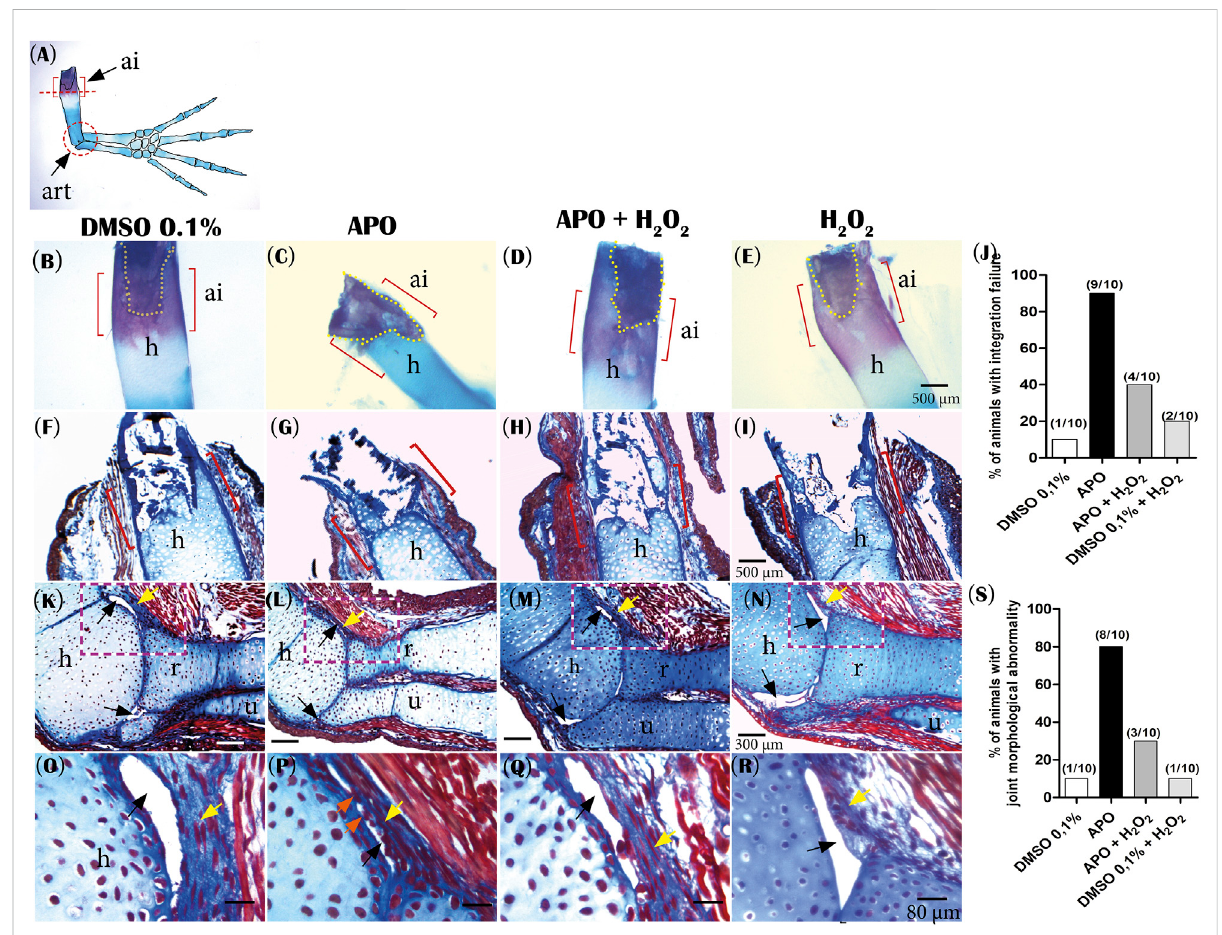
FIGURE 5 Inhibitory treatment of NOXs-dependent ROS production affects the integration of the regenerated skeleton and joint morphology in A. mexicanum at 72 dpa. (A) , Illustration of the areas of interest evaluated: ai (integration area) delimited with red brackets. The red circle indicates the jointareastudied. (B – E) ,representativeimagesoftheexperimentalgroupsevaluatedbyalcianblueandalizarinredstaining:Controlsin0.1%DMSO, apocynin (APO) treatment, rescueassay (APO + H 2 O 2 )and control exposed to 0.1% DMSO +50 µM H 2 O 2 . Yellow dotted lines indicate remnant bone tissue. (F – I) , Histological sections with Masson ’ s trichrome staining at 5 µm. (F) , shows continuity between the regenerated humerus and remnant skeletal tissue in the “ ai ” . (G) , the integration area shows discontinuity between the regenerated and remnant humerus. (H) , application of exogenous H 2 O 2 rescues the phenotype affected by ROS inhibition. (I) , Control animals exposed to 0.1% DMSO + H 2 O 2 show integration between regenerated skeletal tissue and remnant skeletal tissue. (J) , Percentage of animals that presented integration failure in the different experimental groups. (K,L) Representative images of joint morphology. (K) , typical synovial joint morphology. (L) , APO treatment affects the joint capsule and generates constriction of synovial spaces. (M) , treatment with exogenous H 2 O 2 rescues the articular morphology. (N), DMSO + H 2 O 2 treatments do not affect typical joint morphology. (O – R) , magni fi cation of area delimited with red dotted lines in K, L, M, and N. (O) A well-de fi ned synovial space can be observed. (P) Animals treated with apocynin show a fairly constricted synovial space with apparent continuity between the connective tissue ofthearticularcapsuleandthearticularsurfaceoftheregeneratedhumerus(orangearrows). (Q) Similartocontrols,amorede fi nedsynovialspaceis observed. (R) An articularmorphology as seen in the DMSO controls can be observed. (S) , Percentage of animals that presented joint morphological abnormality in the evaluated groups. Yellow arrows indicate connective tissue joint capsule. Black arrows indicate synovial spaces. ai, integration area; h, regenerated humerus; r, radius; u,